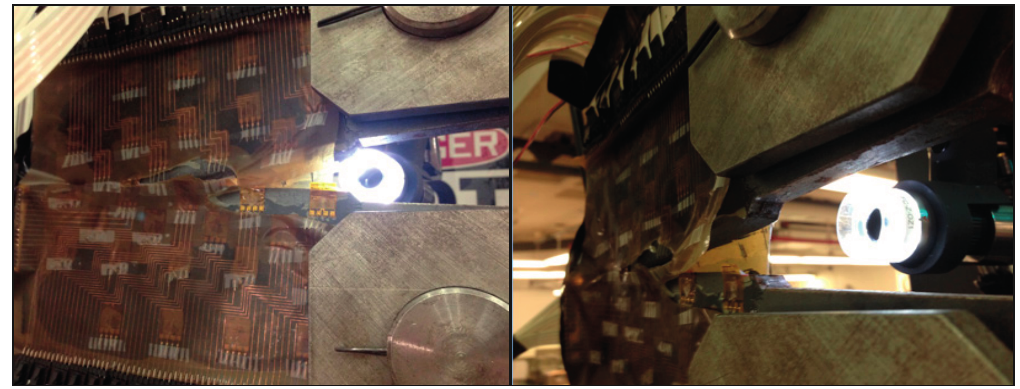
Figure 14. Failure of Plate #2 (sensing sheets Design 1). ( Left ): frontal view of the crack; ( Right ): side view of the